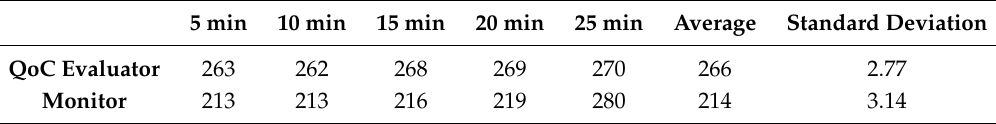
Table 6. Memory consumption in Kilobyte (Kbytes).